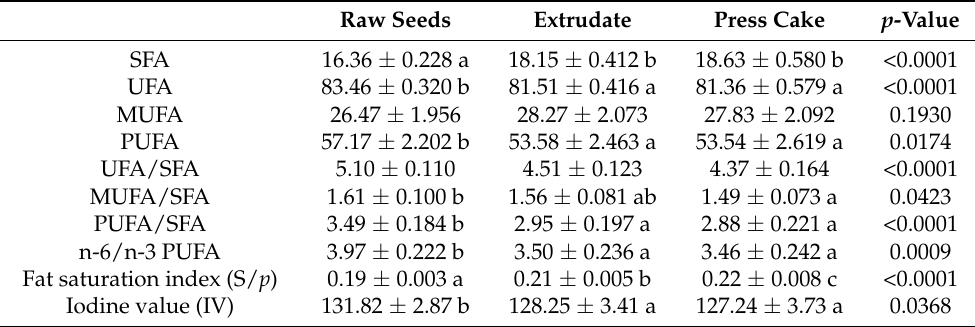
Table 9. The fatty acid profile and fat quality indicators for the raw soybean seeds and feed products (the mean values from 3 soybean varieties ±